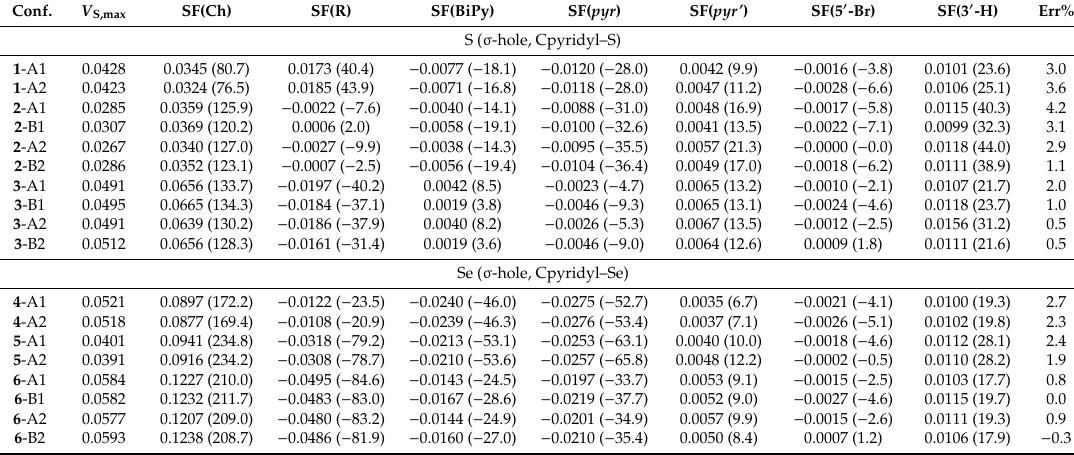
Table 4. V S,max (au) and their Source Function (SF) atomic group contributions on C pyridyl –Ch (Ch = S, Se) σ -holes (0.002 au molecular surface) calculated for the various conformers of systems 1 – 6 . In parentheses the SF percentage values are reported. The Err% value (see text) provides a measure of the SF V S,max reconstruction accuracy.